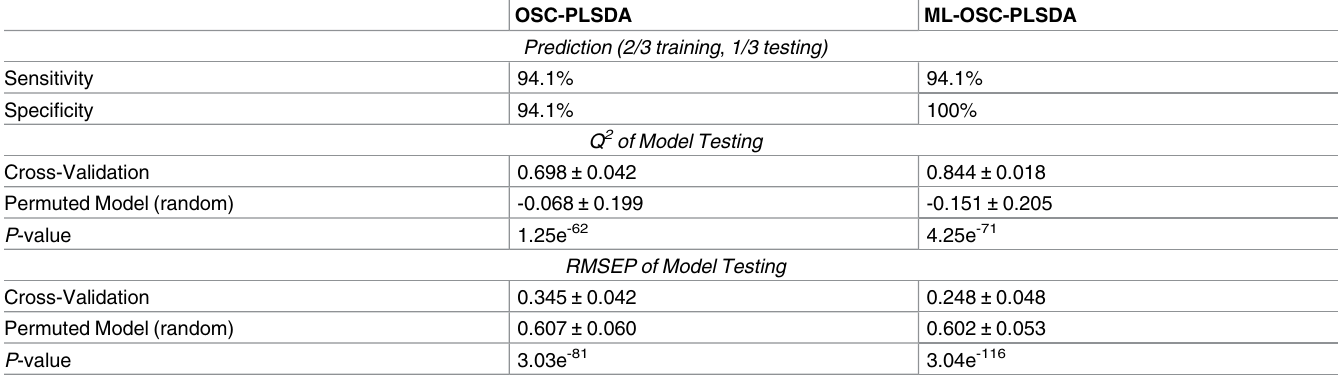
Table 1. Sensitivity, specificity, and testing of predictions from the orthogonal signal-corrected